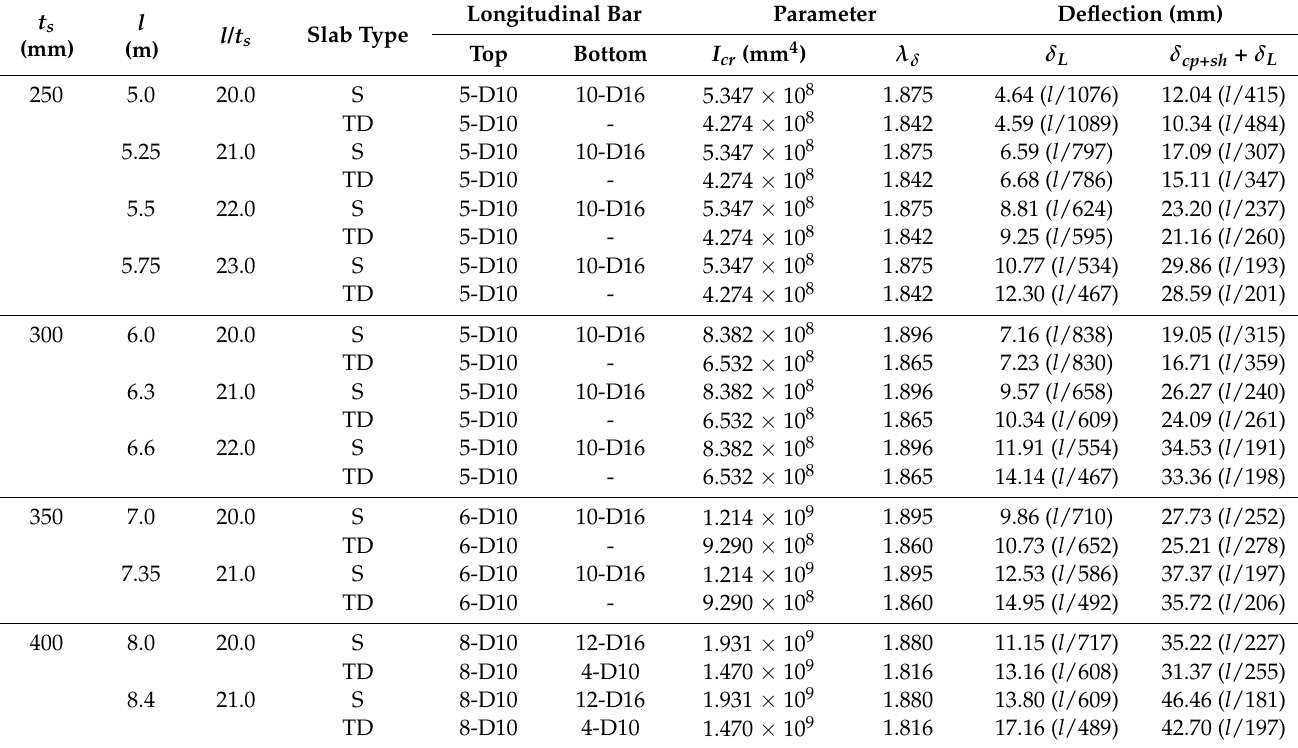
Table 6. Deflection comparison of TD slabs and S slabs with the same strength